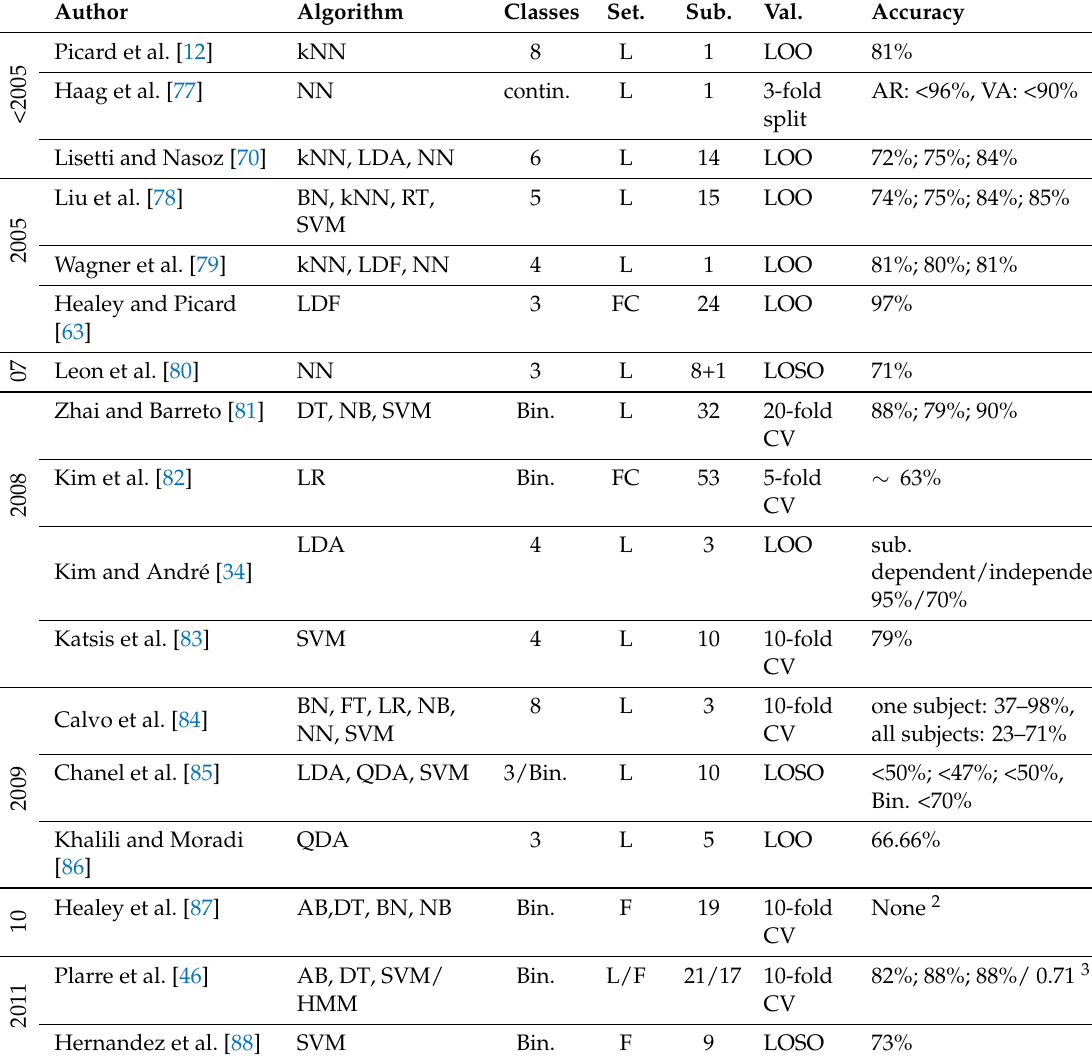
Table 9. Comparison of algorithms, validation methods, and accuracies of recent wearable-based AR studies. If not stated differently, scores are reported as (mean) accuracy. Abbreviations: Setting (Set.), Lab (L), Field (F), Field with constraint (FC), Validation (Val), cross-validation (CV), Leave-One-Out (LOO), leave-one-subject-out (LOSO), Leave-One-Trial-Out (LOTO), Arousal (AR), Valence (VA), Dominance (DO), Liking (LI), AdaBoost (AB), Analysis of Variance (ANOVA), Bayesian Network (BN), CNN, deep belief network (DBN), Gradient Boosting (GB), Gaussian Mixture Model (GMM), Hidden Markow Model (HMM), linear discriminant analysis (LDA), Linear Discriminant Function (LDF), Logistic Regression (LR), Naive Bayes (NB), NN, Passive Aggressive Classifier (PA), random-forest (RF), Decision/Regression/Function Tree (DT/RT/FT), Ridge Regression (RR), Quadratic Discriminant Analysis